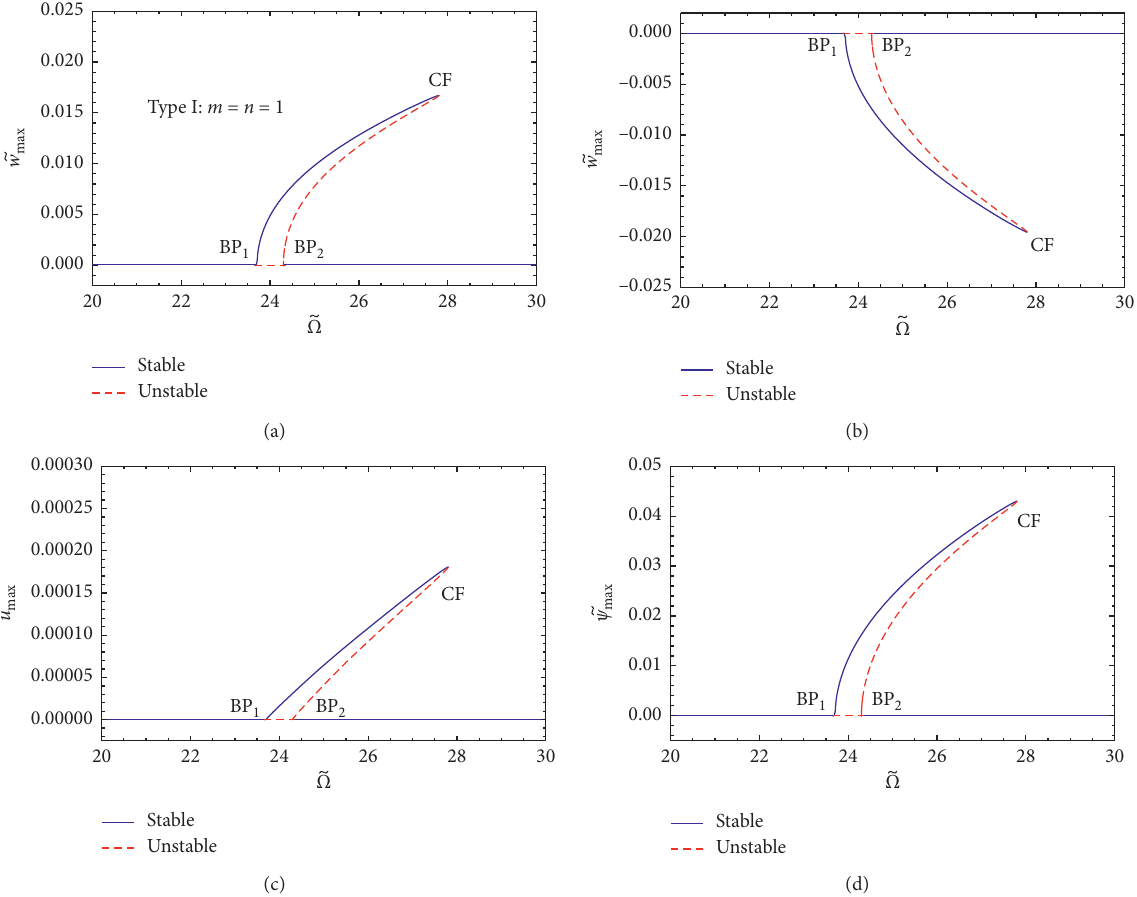
Figure 3: Frequency-response curves of the couple motions of BDFG beam with m � n � 1, L / h � 20, 􏽥 c (a, b) Maximum and minimum amplitudes of transverse motion 􏽥 w . (c) Maximum amplitudes of longitudinal motion 􏽥 u . (d) Maximum amplitudes of rotational motion ψ .